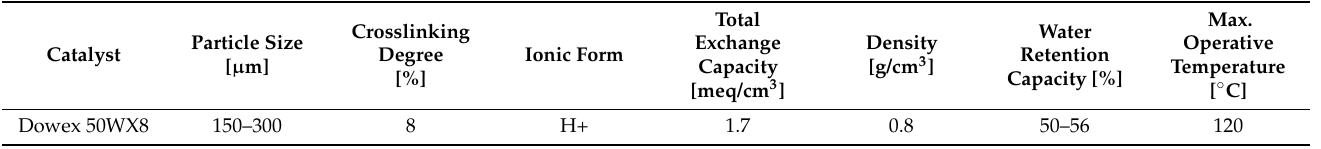
Table 1. Physical properties of the used Dowex 50WX-8 catalyst.